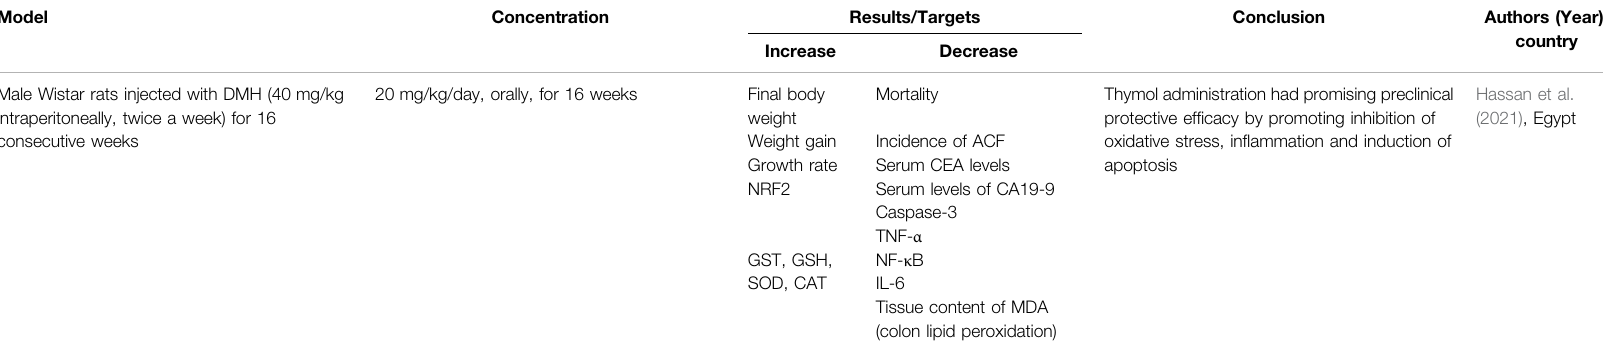
Abbreviations: 5RP7, Mouse embryonic fi broblast with transformation of H-ras oncogenes; 8-OHdG, 8-hydroxy-2 ′ -deoxyguanosine; A375, Melanoma (skin) cancer cell line; A549, Lung Carcinoma Cell Line; ACF, Aberrant crypt foci; AFP, Alpha-fetoprotein serum; AFU, Alpha l-fucosidase; AgNORs, Proteins Associated with the Argyrophilic Nucleolar Organizing Region; AGS, Human gastric carcinoma cell line; ALP, Alkaline Phosphatase; ALT, Alanine transaminase; AST, Aspartate transaminase; AXL, Tyrosine Kinase Receptor; B[a]P, 3.4 benzopurene; B16-F10, Mouse melanoma cells; BT-474, Breast ductal carcinoma; BT-483, Breast ductal carcinoma; C6, Glioma cell line; Caco-2, Cell line derived from human colon carcinoma; CA 19 – 9, Tumor markers carbohydrate antigen 19 – 9; Cal27, Cell line of the squamous cell carcinoma of the tongue; CAT, Catalase; CEA, Carcinoembryonic antigen; CCK-8, Cell Counting Kit-8; CCND1, Gene encodingthecyclinD1protein;CDK4or6,Cyclin-dependentkinases;cGT,GlutamyltranspeptidaseRange;CyTC,CytochromeC;c-Myc,Proto-oncogene;CO25,Mousemusclecellline;COX-2,Cyclooxygenase;DAPK1,Proteinkinase1 associated with death; DBTRG-05MG, Human Glioblastoma Cells; DEN, Diethylnitrosamine; DMH, 1,2-dimethylhydrazine; DMBA, 7,12-dimethylbenz[a]anthracene; DMSO, Dimethylsulfoxide; DNA, Deoxyribonucleic acid; DU 145, Human ProstateCancerCell Line;EC50, Half ofthemaximumeffectiveconcentration; EMF,AcuteT LymphoblastoidLeukemia; EMT,Epithelial-mesenchymal transition;ERK1/2,Kinase1/2regulatedbyextracellularsignal;ERO, Reactive Oxygen Species; GGT,Gamma-Glutamyltransferase; GPx, GlutathionePeroxidase; GR,Glutathionereductase; GSH,ReducedGlutathione;H1299,ParentalandDrugResistant HumanLung CancerCell Line;H460,Non-small celllungcancercell line;HCT116,Colorectaladenocarcinomacellline;HeLa,HumanCervicalCancerCellLine;Hep,HumanLaryngealSquamousCellCarcinoma;Hep3B,HumanHepatocellularCarcinomaCellLine;HepG2,HumanHepatocellularCarcinoma Cell Line; HL-60, Human Acute Promyelocytic Leukemia Cell Line; HT-29, Colorectal adenocarcinoma cell line; IC50, Half of the maximum inhibitory concentration; IL-6, Interleukin-6; J82, Bladder Cancer Cell Line; Jagged-1, Jagged Canonical Notch Ligand 1; JAR, Human Choriocarcinoma Cell Line; JEG3, Human Choriocarcinoma Cell Line; Jurkat, Lymphocytes derived from T-cell lymphoma; KG1 and K-562, Human Myelogenous Leukemia Cell Line; Kelly, Neuroblastomacellline;Ki-67,Antigen,biomarker;KLN205,Non-smallcelllungcancer;LDH,Lactatedehydrogenase;LoVo,ColorectalAdenocarcinomaCellLine;MAPK,Proteinkinaseactivatedbymitogen;MTT,MethylTetrazoliumTest; MTS,Tetrazoliumsaltreduction;MCF-7,Humanbreastcancercellline;MCF-7gem,Gemcitabine-resistanthumanbreastadenocarcinoma;MDA,Malondialdehyde;MDA-MB231,Humanmetastaticbreastadenocarcinomacellline;MDA- MB453,Humanmetastaticbreastadenocarcinomacellline;MDPK,Myotonicdystrophyproteinkinase;MG63,HumanOsteosarcomaCellLine;MMP,Potentialofthemitochondrialmembrane;MMP-2or9,Metalloproteinase-2or9ofthe matrix;N2a,Ratneuroblastomacellline;NDEA,N-nitrosodiethylamine;Notch-1,Signalingpath;NSCLC,Non-smallcelllungcancer;OC2,Humanoralcancercells;OSCC,Humanoralsquamouscellcarcinoma;p21,WAF1encodinggene; p38,Mitogen-activatedproteinkinases;p53,tumorprotein;P-815,MurineMastocytomaCellLine;p-AKT,Phospho-proteinkinaseB;PBS,Sterilephosphatebufferedsaline;PC-3,HumanProstateCancerCellLine;PCNA,ProliferatingCell Nuclear Antigen; PI3K/AKT/mTOR, Phosphoinositide-3-kinase/Akt/mammalian target; PI3K/Akt, Phosphoinositide-3-kinase-Akt; p-JNK, Fosto-c-Jun N-terminal kinase; p-p38, Phospho-p38; PPP2R2A, Serine/threonine-protein phosphatase 2A; p-STAT3, Phospho-signal transducer and transcription activator; SRB, Sulforhodamine B; SCC-25, Human squamous cell carcinoma cell line; SCC4 and SCC9, Human oral squamous cell carcinoma cell line; SH-SY5Y, Neuroblastoma cell line; SiHa, Human Cervical Cancer Cell Line; SKOV-3, Ovarian cancer cell line; SOD, Superoxide dismutase; SW780, Bladder cancer cell line; T24, Bladder Cancer Cell Line; TAC, Total antioxidant capacity; TBARS, ThiobarbituricAcidReactiveSubstances;TCA-8113,Humantonguesquamouscellcarcinomacellline;TNF- α ,TumorNecrosisFactor-Alpha;TNFR1,Tumornecrosisfactor1receptor;TOS,Totaloxidantstatus;TRPM7,SubfamilyMofthe cation channel of the potential transient receptor Member 7; U87, Human glioblastoma cell line; VEGF, Vascular endothelial growth factor; XXT, 2.3-bis(2-methoxy-4-nitro-5-sulfophenyl)-2H-tetrazolium-5-carboxanilide inner